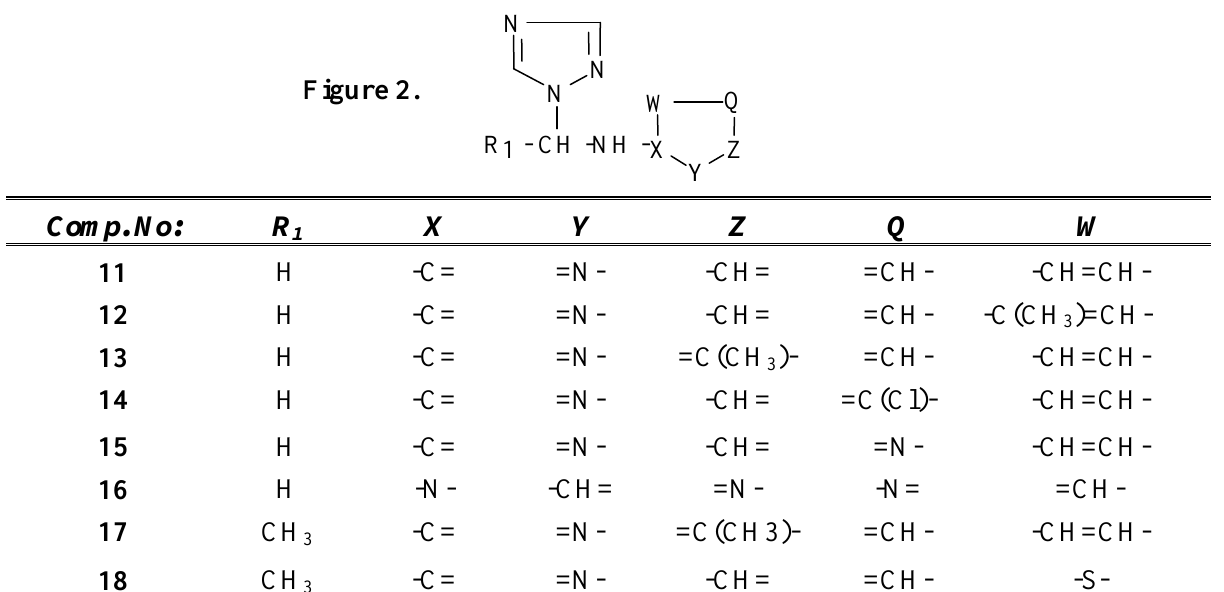
Table 2. N 1 -heteroarylaminomethyl/ethyl-1,2,4-triazole derivatives ( 11-18 ) used in the present